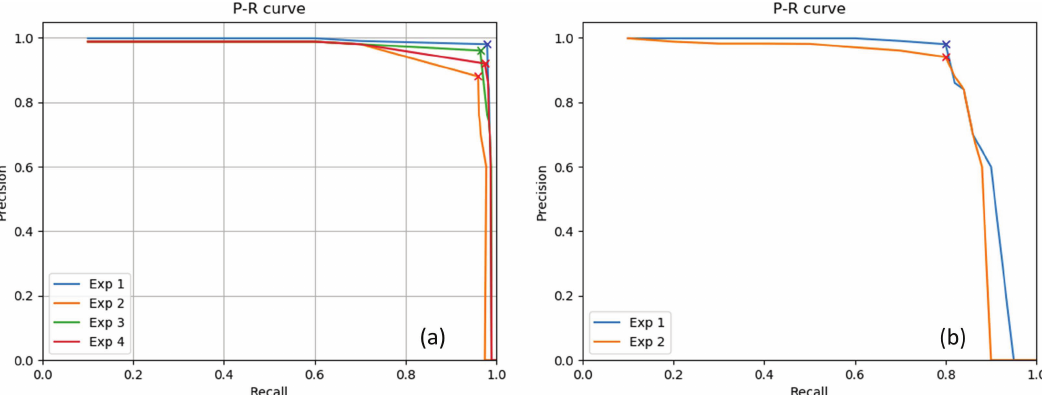
Figure 12. Precision and Recall curves for τ = 0.5 (‘x’ marks the optimal configurations). ( a ) Robustness to hardware variations and ( b ) Robustness to noise caused by nearby objects.